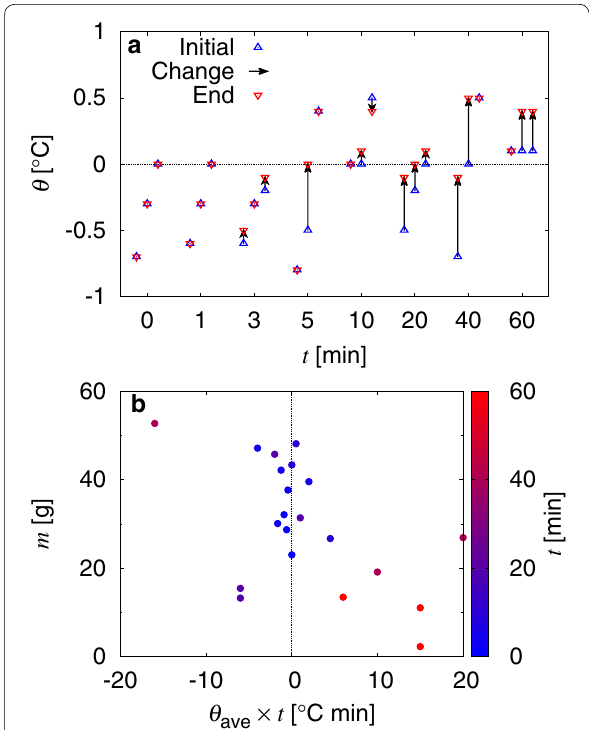
Fig. 6 Change of aggregate mass with air temperature. Effect of air temperature, θ , measured around the rotating table on the evolution of the aggregate mass, m , with time in EXP1 ( d t = 32 – 63 µ m , C t = 33% , and C s = 9% ): a change in θ at each rotation time t and b m vs. θ ave times t . Blue up-pointing and red down-pointing triangles in a denote θ before and after rotation, respectively. The horizontal axis of b θ ave × t indicates heat transport from the air into the mixture, where θ ave is calculated by Eq. (7)